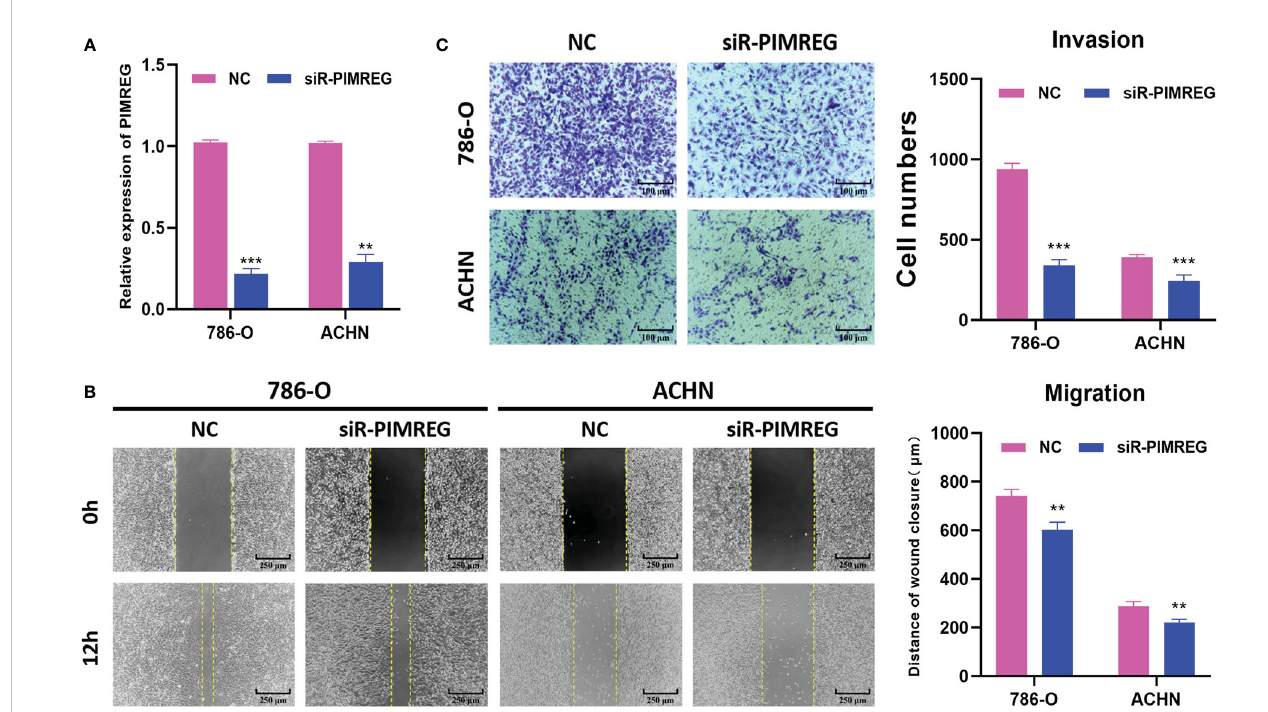
FIGURE 10 PIMREG promotes ccRCC cells migration and invasion in vitro . (A) The mRNA expression level of PIMREG was measured by qRT-PCR after cell transfection. (B) Wound healing assay indicated that knockdown of PIMREG reduced the migratory ability of ccRCC cells. (C) Transwell invasion assay indicated that knockdown of PIMREG reduced the invasive activity of ccRCC cells. ccRCC: clear cell renal cell carcinoma; **P < 0.01, ***P <